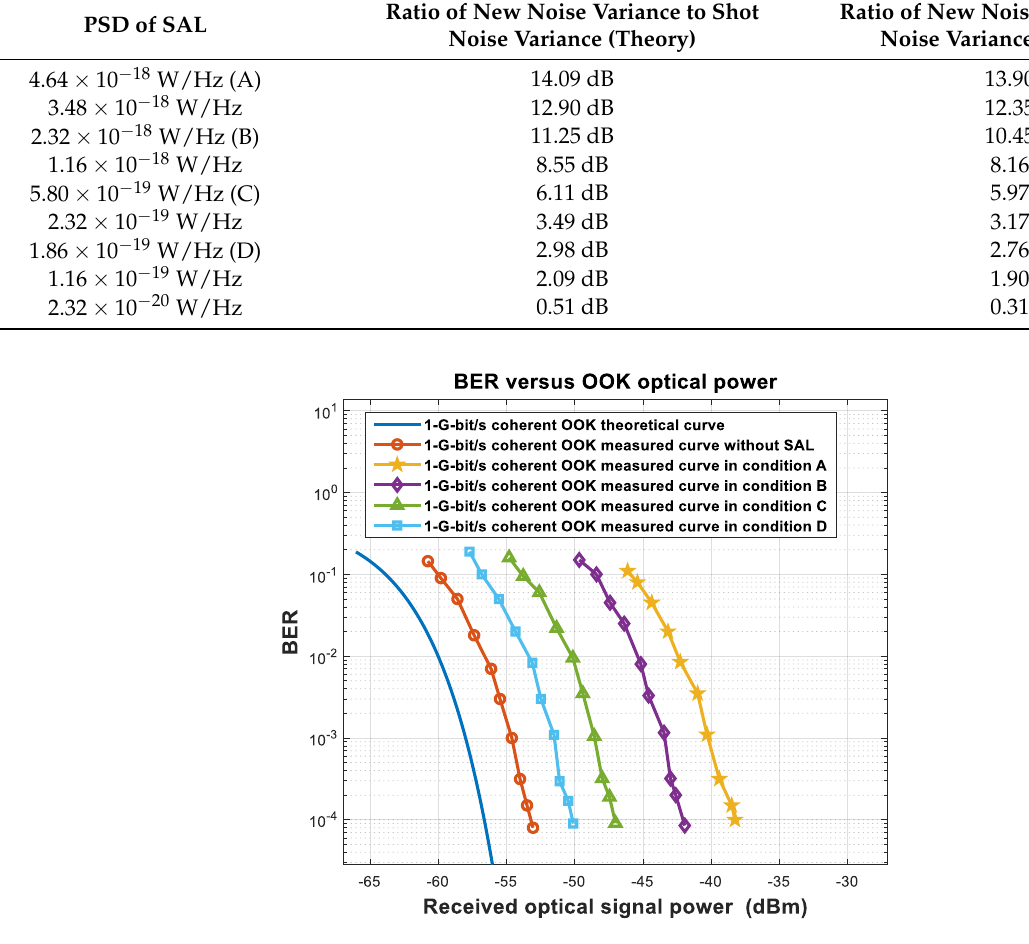
Figure 13. BER vs. coherent OOK optical power in different conditions.